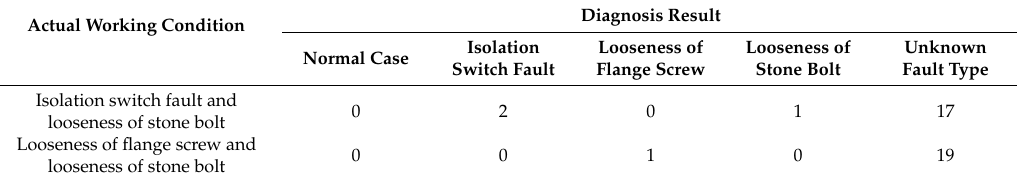
Table 7. Diagnosis results of two composite